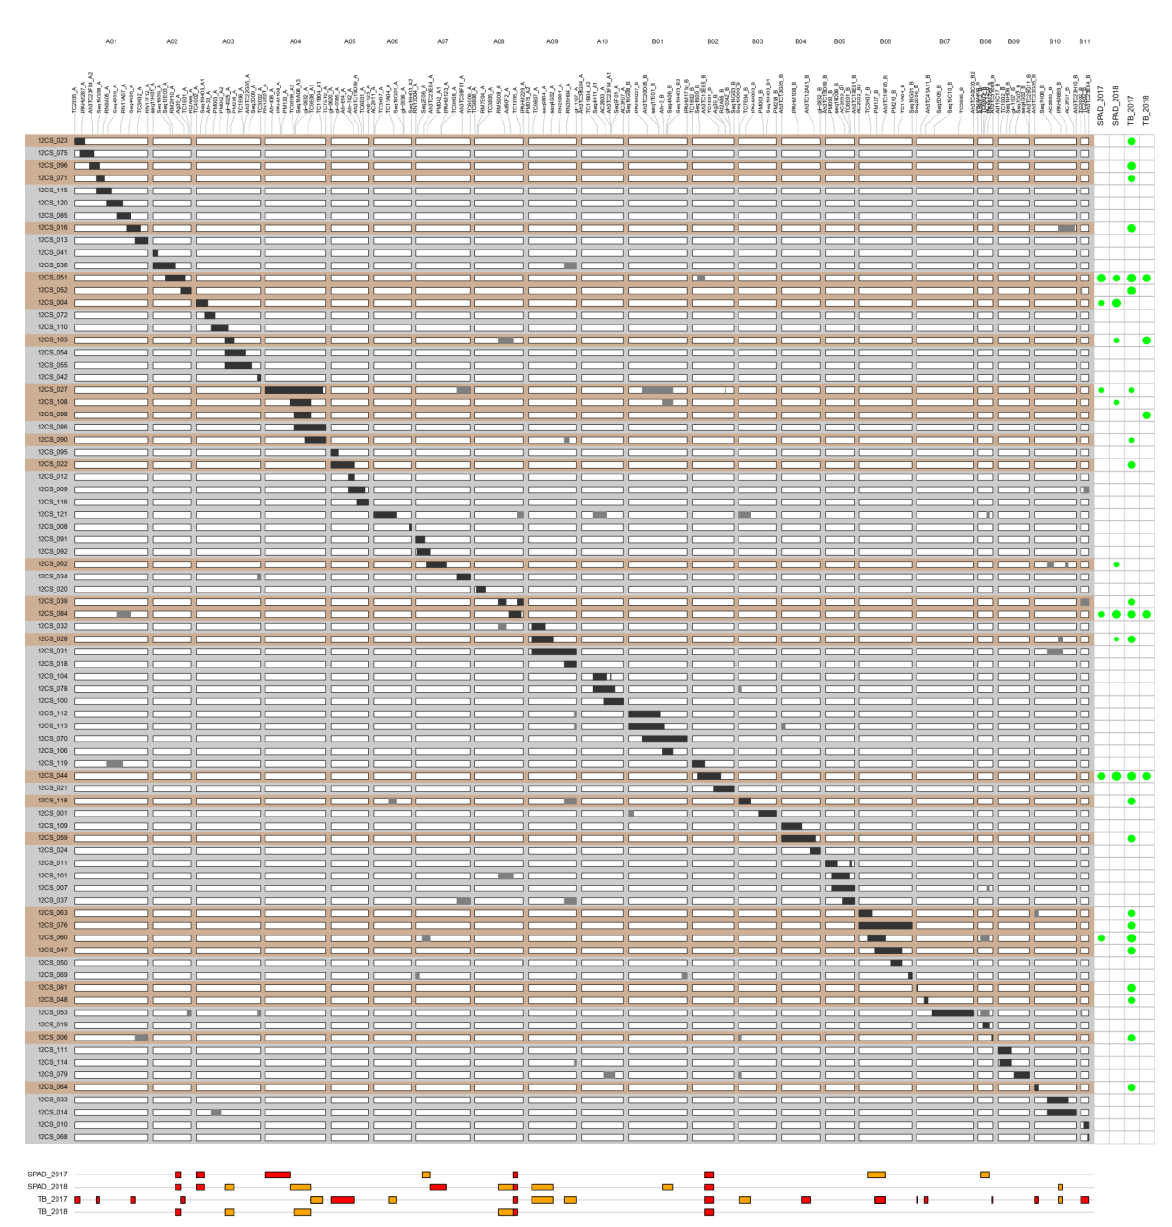
Figure 1. Position of QTLs related to BNF in the genetic map of peanuts. Each column indicates a linkage group named from A01 to A10 (A genome) and B01 to B11 (B genome). Each row indicates a CSSL. The white background represents the genetic background of the recurrent parent Fleur11. The black areas represent the wild target chromosome segments, while the grey areas represent the wild supernumerary chromosome segments. CSSLs showing significant differences compared to Fleur11 are highlighted in orange. The green circles on the left of the figure represent the relative effect on the QTL. Their sizes are proportional to the QTL ’s relative effect. SPAD and TB correspond to the leaf chlorophyll content and the total biomass, respectively, evaluated in 2017 and 2018. All the QTLs identified had a negative effect on the measured traits. QTL locations are indicated by rectangles located at the bottom of the figure. Red = QTL with known location, orange = putative QTL.